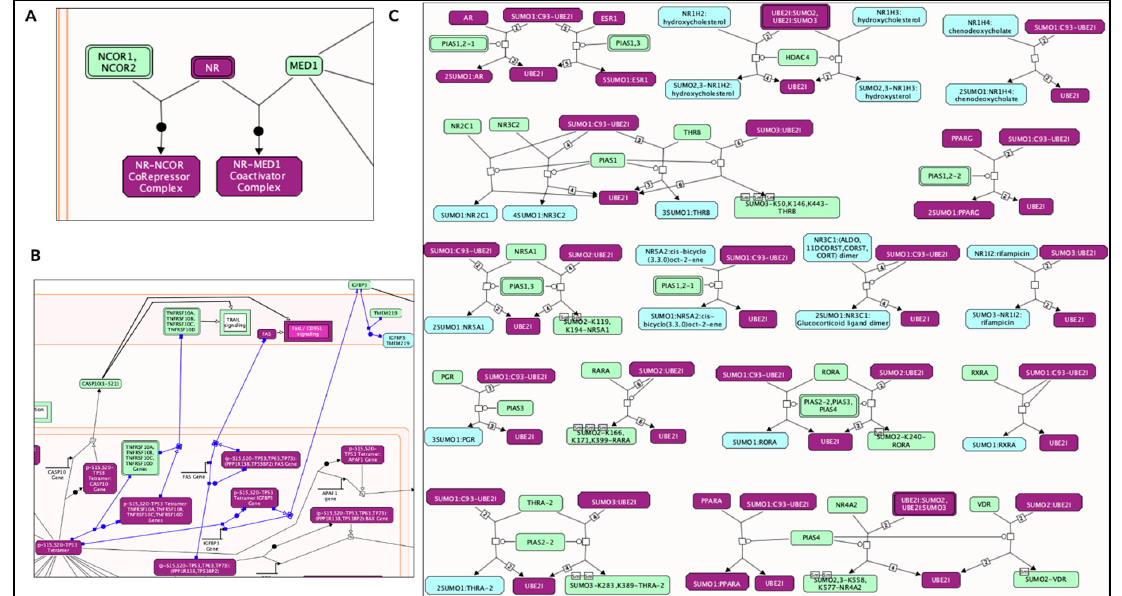
Figure 2. Enriched pathway analysis. The entities colored purple are hits within the positive gene list. Proteins are rectangles whereas elongated hexagons are complexes. ( A ) Generic transcription pathway. ( B ) TP53 Regulates the transcription of death receptors and ligands. ( C ) SUMOylation of intracellular receptors.